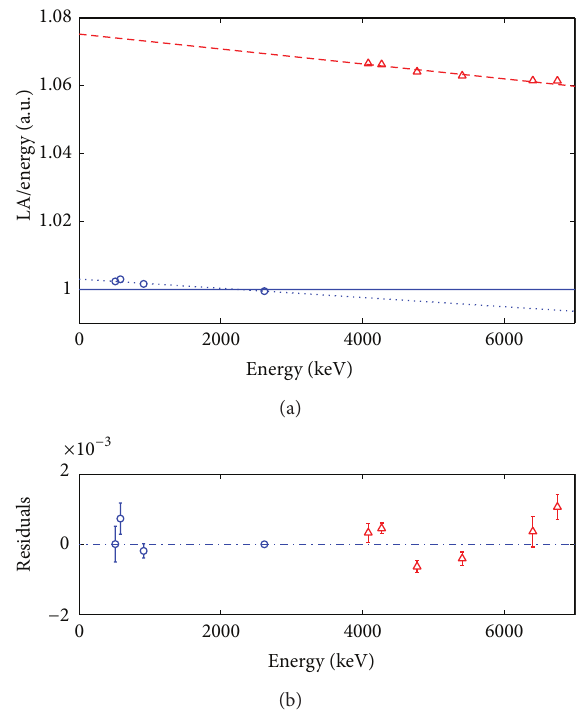
Figure 7: (Color online) ratio of signal amplitude (LA) and energy in linear calibration for 𝛾 (circle, blue) and 𝛼 (triangle, red) peaks (a). Quadratic calibration lines (dotted and dashed lines) are shown for 𝛾 and 𝛼 peaks, respectively. Deviations of the ratios from each quadratic functions are shown in (b).